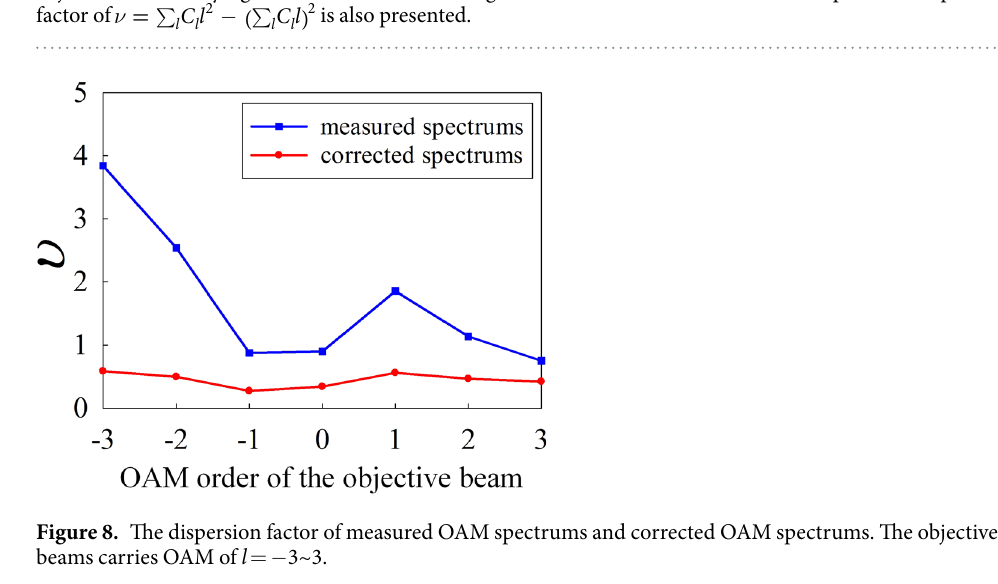
and the precision in our system is about10 − 4 rad .